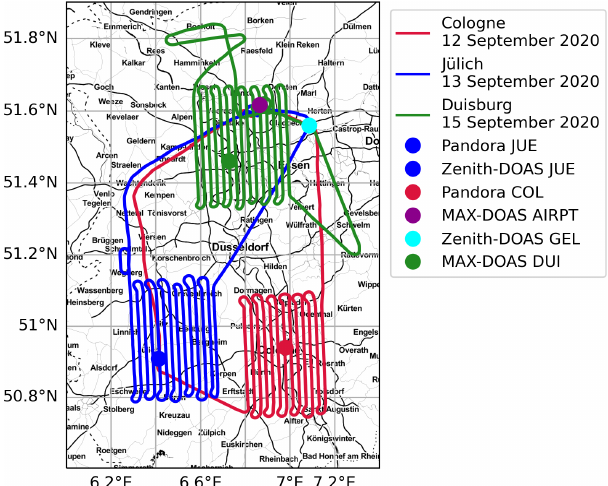
Figure 2. Overview of the flight area of the Ruhr campaign, in- cluding exemplary flight patterns in the three target areas and loca- tions of the stationary instruments in Jülich (blue), Cologne (red), Dinslaken airport (purple), Gelsenkirchen (cyan), and Duisburg